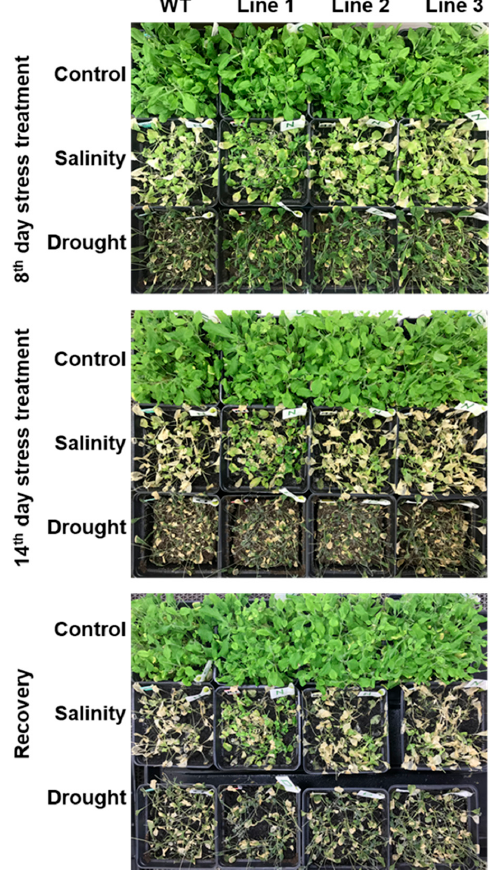
Figure 8. Performance of the PdMT2A transgenic and WT Arabidopsis plants grown on soil and subjected to salinity (200 mM NaCl) and drought stress for 14 days.